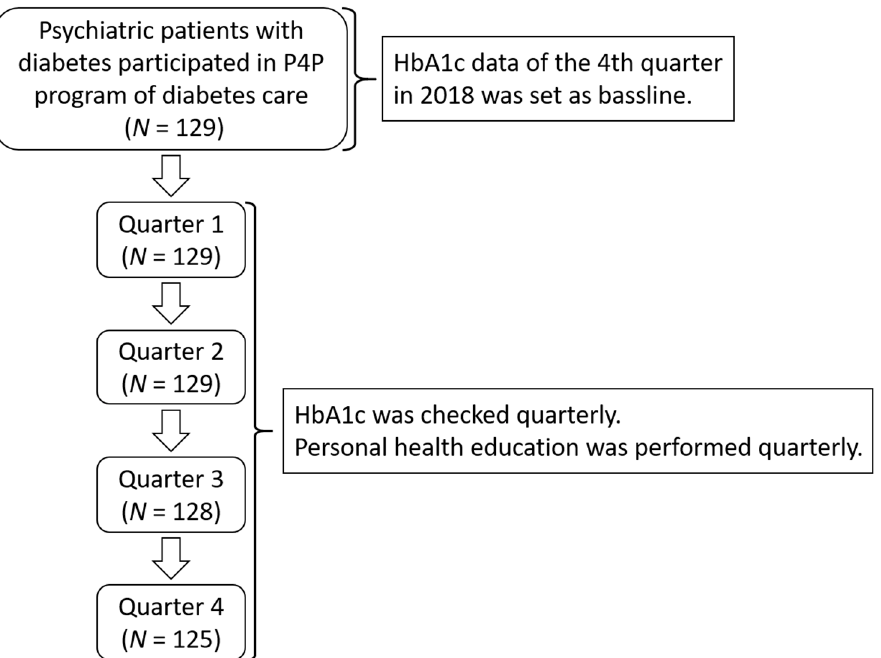
Figure 1. Flow diagram of our study. A total of 129 psychiatric patients with diabetes were included in the beginning. One patient loss to follow-up in the third quarter, and another three patients loss to follow-up in the fourth quarter. P4P: pay-for-performance; HbA1c: hemoglobin A1c.